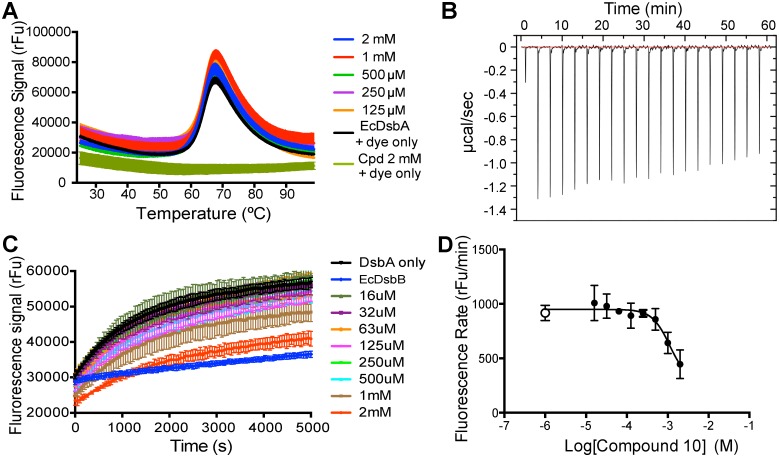
Compound 10 demonstrated weak inhibitory activity.
A. Differential scanning fluorimetry profile with increasing concentrations of compound 10. Similar to all other compounds tested, there was no significant shift in the unfolding temperature of EcDsbA up to 2 mM of compound 10. B. ITC profile of EcDsbA titration by compound 10, which shows no detectable binding under the conditions used (see methods for details). A similar outcome was found for the other 9 compounds. C. Compound 10 was the only one of the ten tested peptidomimetics that exhibited detectable activity in the DsbA assay, inducing a reduction in DsbA folding activity. D. Plotting the log of the peptidomimetic concentration against the rate of fluorescence increase measured in the enzyme assay allowed fitting of a sigmoidal curve and an estimated IC50 value of ~1 mM for compound 10. The positive control with no compound is shown as a white circle.